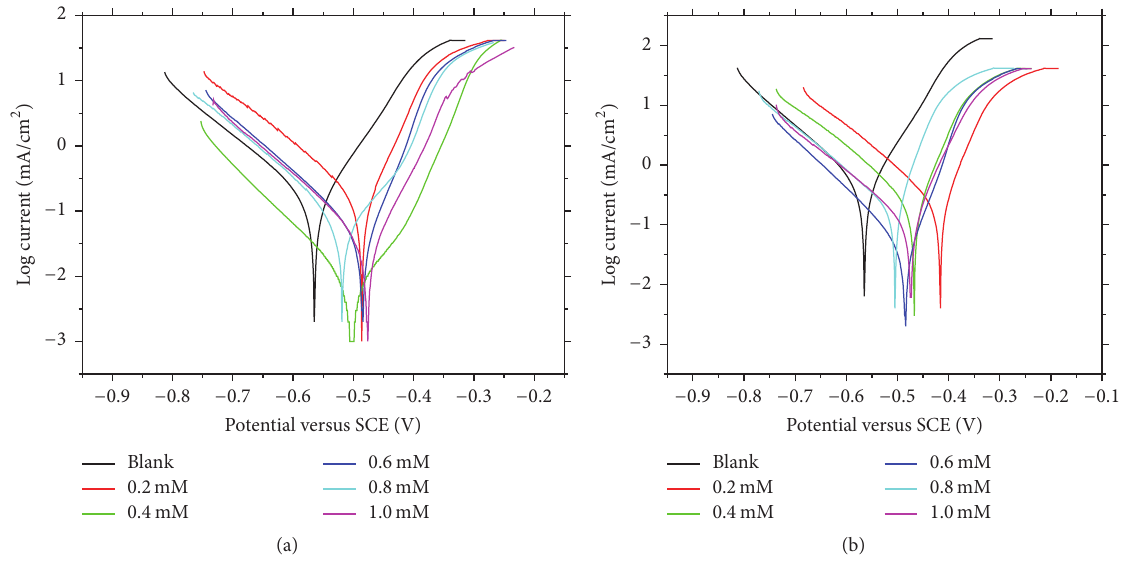
Figure 4: Tafel lines for CS in the absence and presence of (a) P2APH and (b) RP2APH in 1M HCl at 29 ± 0.2 ∘